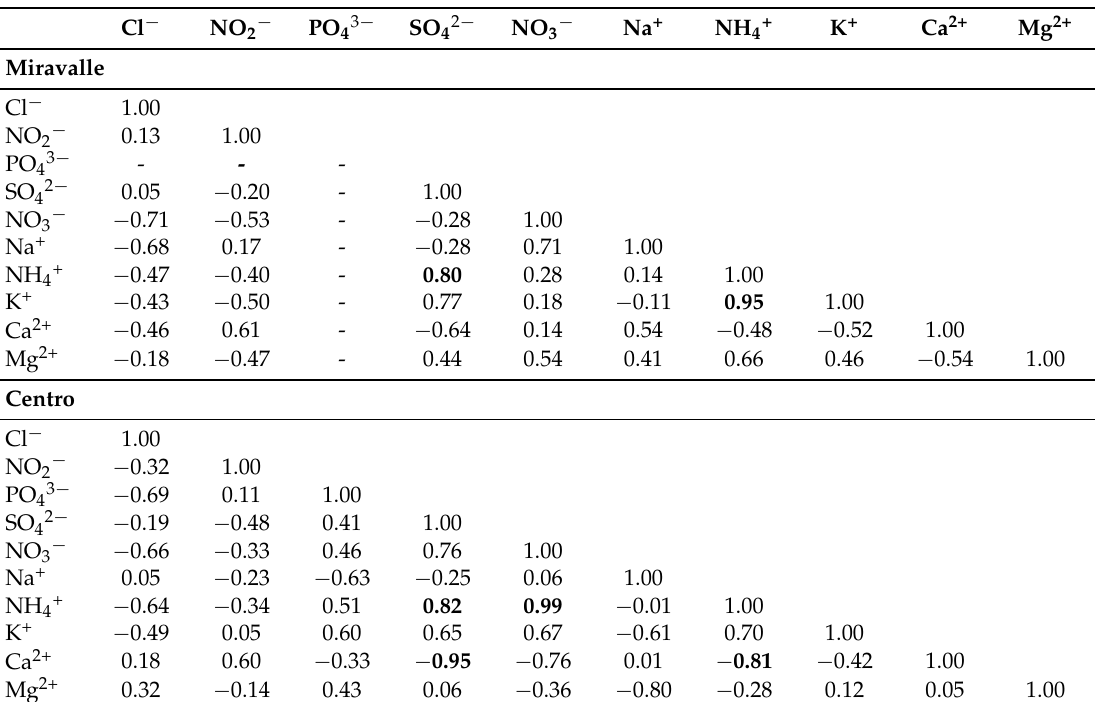
Table 4. Correlation among inorganic ions (bold correlations are significant at p <